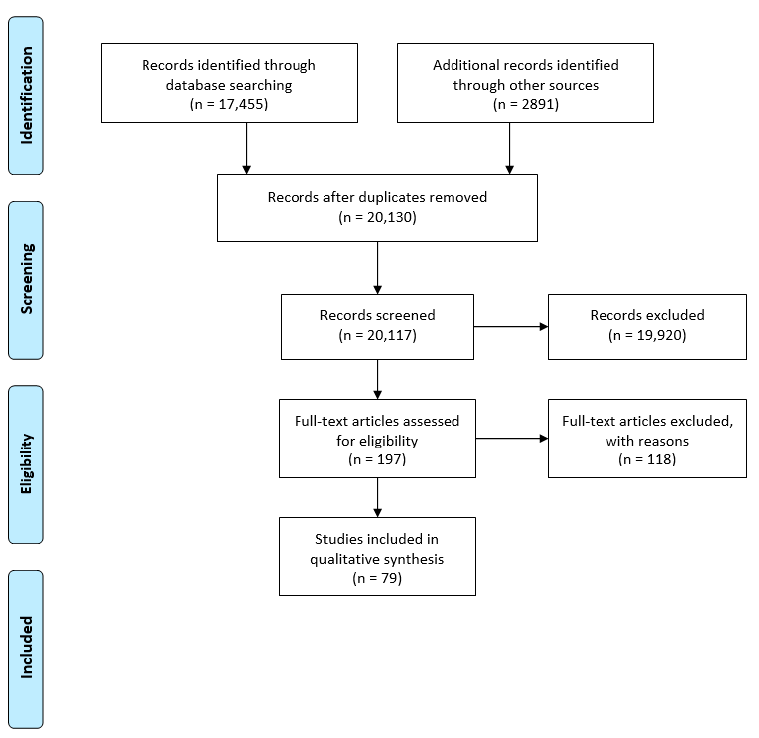
Figure A1. PRISMA 2009 Flow Diagram—Awareness [85]. For more information, visit www.prisma-statement.org.